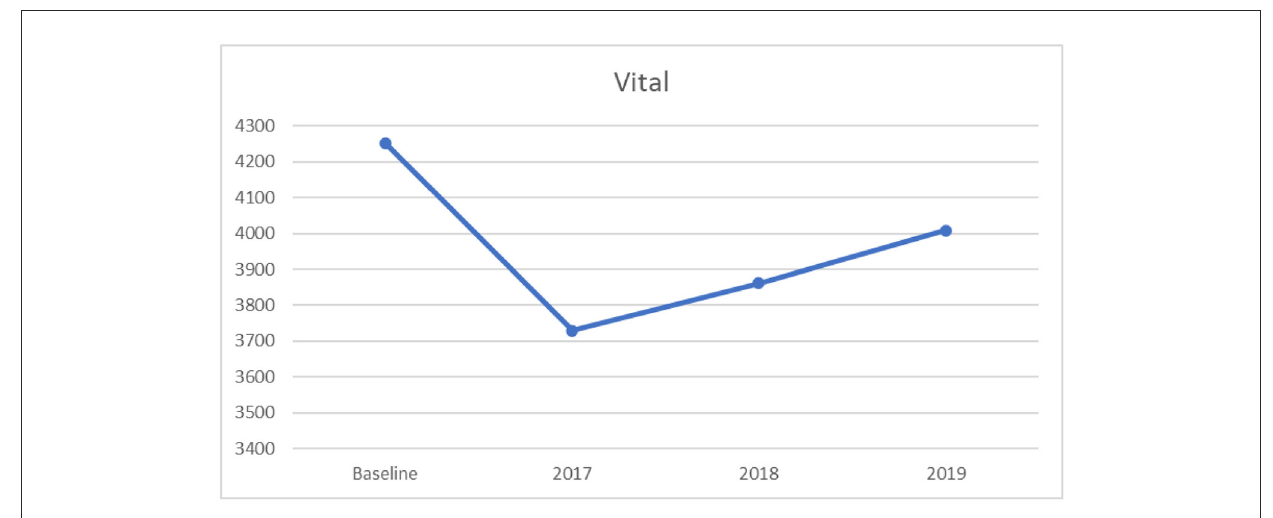
FIGURE1 Mean vital capacity scores: across baseline and years